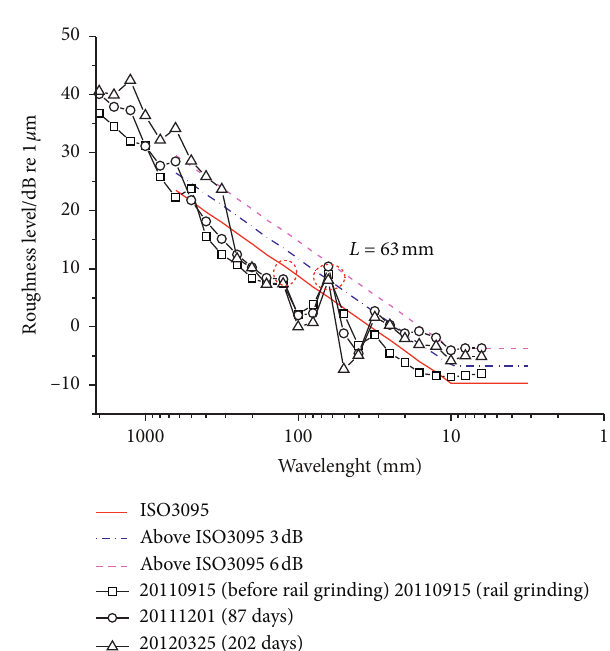
Figure 9: Development of corrugation after rail grinding in left